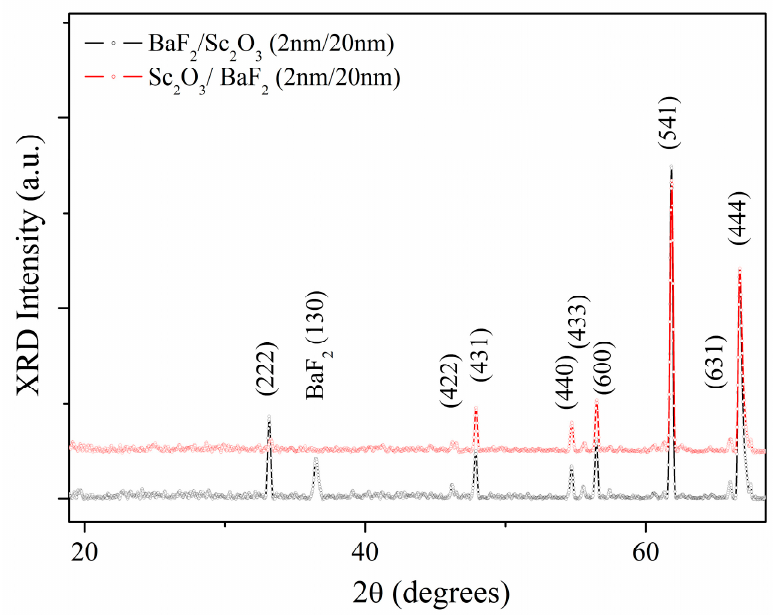
Figure 9. XRD patterns of the BaF 2 /Sc 2 O 3 and Sc 2 O 3 /BaF 2 Figure 9. XRD pa tt erns of the BaF 2 /Sc 2 O 3 and Sc 2 O 3 /BaF 2 samples.